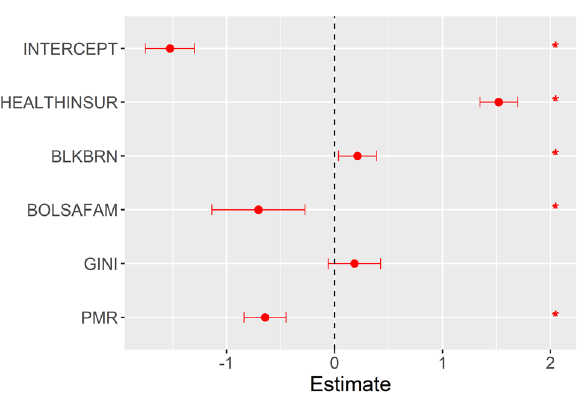
Figure 6. Results of the ZINB spatial–temporal regression models for the standardised case fatality ratio of severe acute respiratory syndrome coronavirus